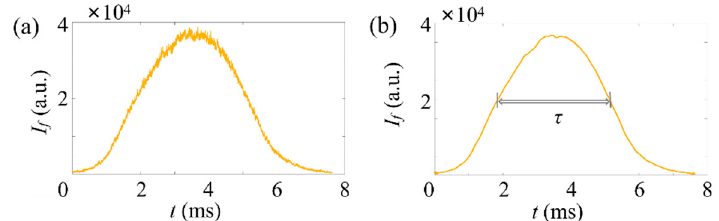
Figure 9. Typical time traces of fl uorescence signals of microspheres in a low particle concentration, = 𝑄 = 1 μL/h . The horizontal axis represents the time, and the vertical ~8 (cid:3400) 10 (cid:2872) mL (cid:2879)(cid:2869) . Here, 𝑄 𝑠 𝑗 axis represents the signal strength. Here, a low gain is applied for the PMT. ( a ) Raw data, ( b ) after noise